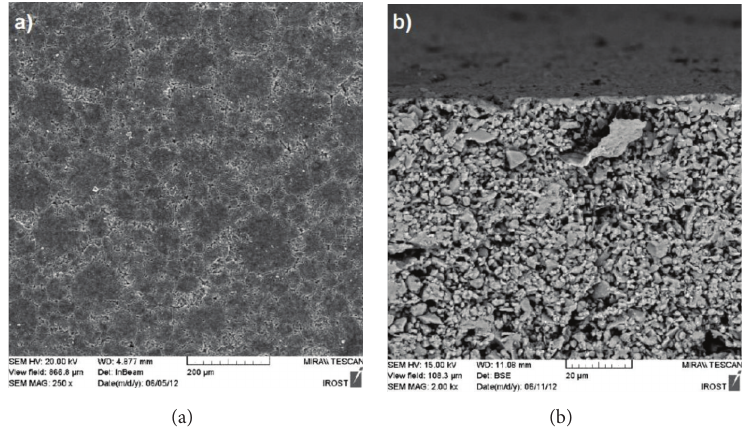
Figure 3: FESEM images of the (a) surface and (b) cross-section of the alumina substrate.